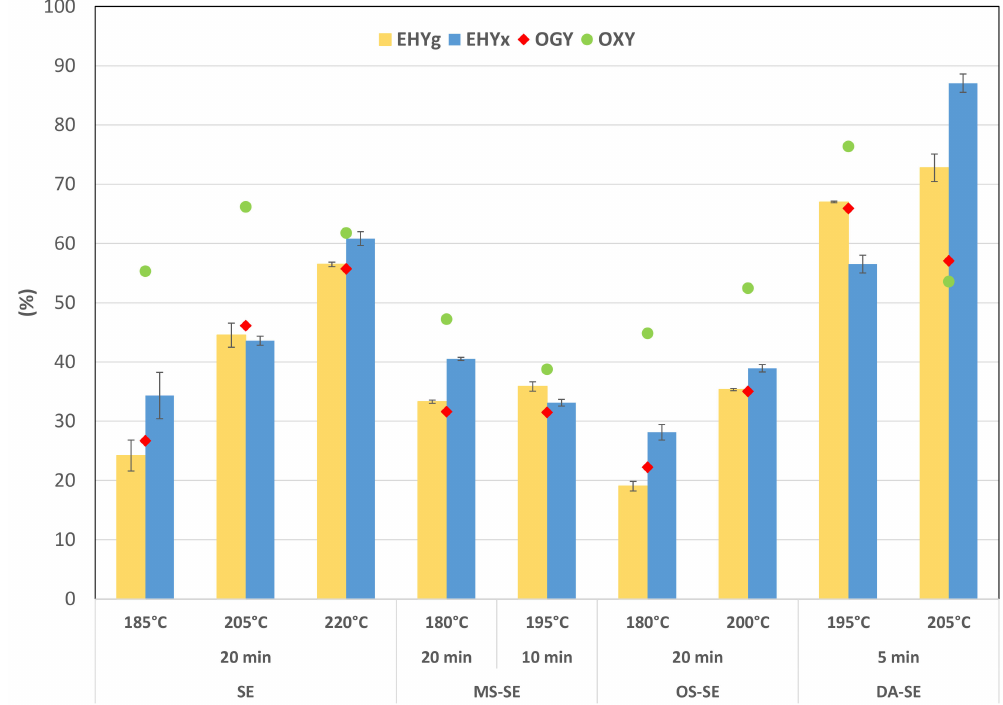
Figure 2. Enzymatic hydrolysis glucan (EHYg) and xylan (EHYx) yields 1 and overall glucose (OGY) and xylose (OXY) yields 2 from WIS obtained at di ff erent pretreatment conditions. 1 Data are expressed as a percentage of potential glucose (or xylose) on the pretreated MFGW. 2 Data are expressed as a percentage of potential glucose (or xylose) on untreated